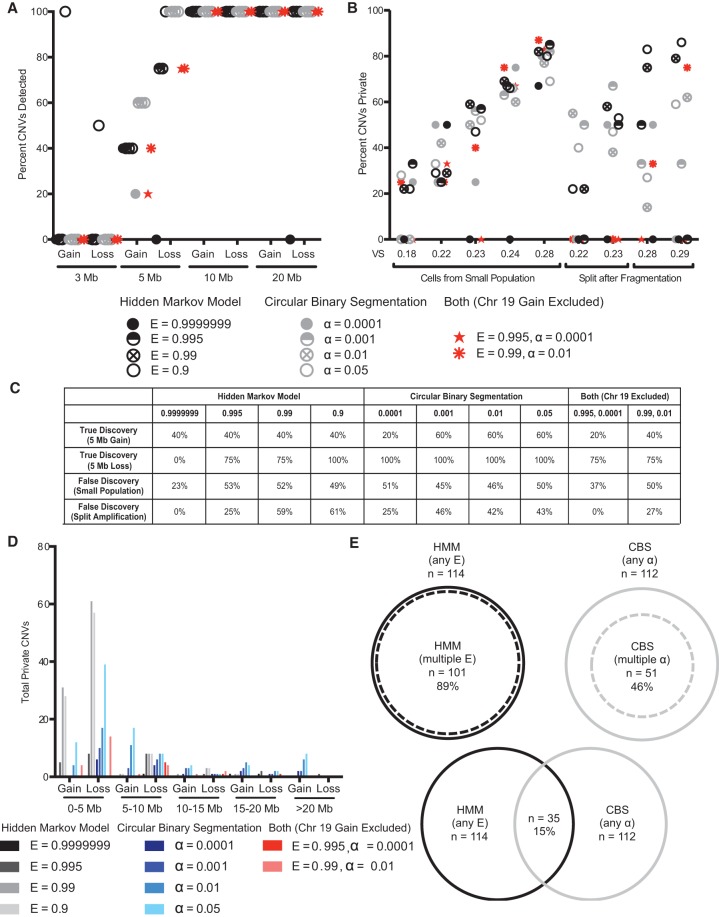
Testing sensitivity and specificity of CNV detection in single-cell sequencing data. (A) The discovery rate of known CNVs ranging from 3 to 20 Mb in single cells using HMM, CBS, or both at different values of E or α. Four or five cells were sequenced for each CNV. (B) The average proportion of CNVs that are private in individual cells sharing a recent ancestor or DNA split after fragmentation from a single cell when analyzed by HMM, CBS, or both at various parameters. (C) The true discovery rates (for 5-Mb gains and losses) and the false discovery rates (averaged across samples from small population or split amplification) for CNV detection using HMM, CBS, or both at different values of E or α, regardless of VS. (D) The distribution of private CNV type and size in individual cells sharing a recent ancestor or DNA split after fragmentation from the same cell when analyzed by HMM, CBS, or both at various parameters. (E) The proportion of private CNVs called by more than one parameter of HMM or CBS and the proportion of private CNVs called by both HMM and CBS.